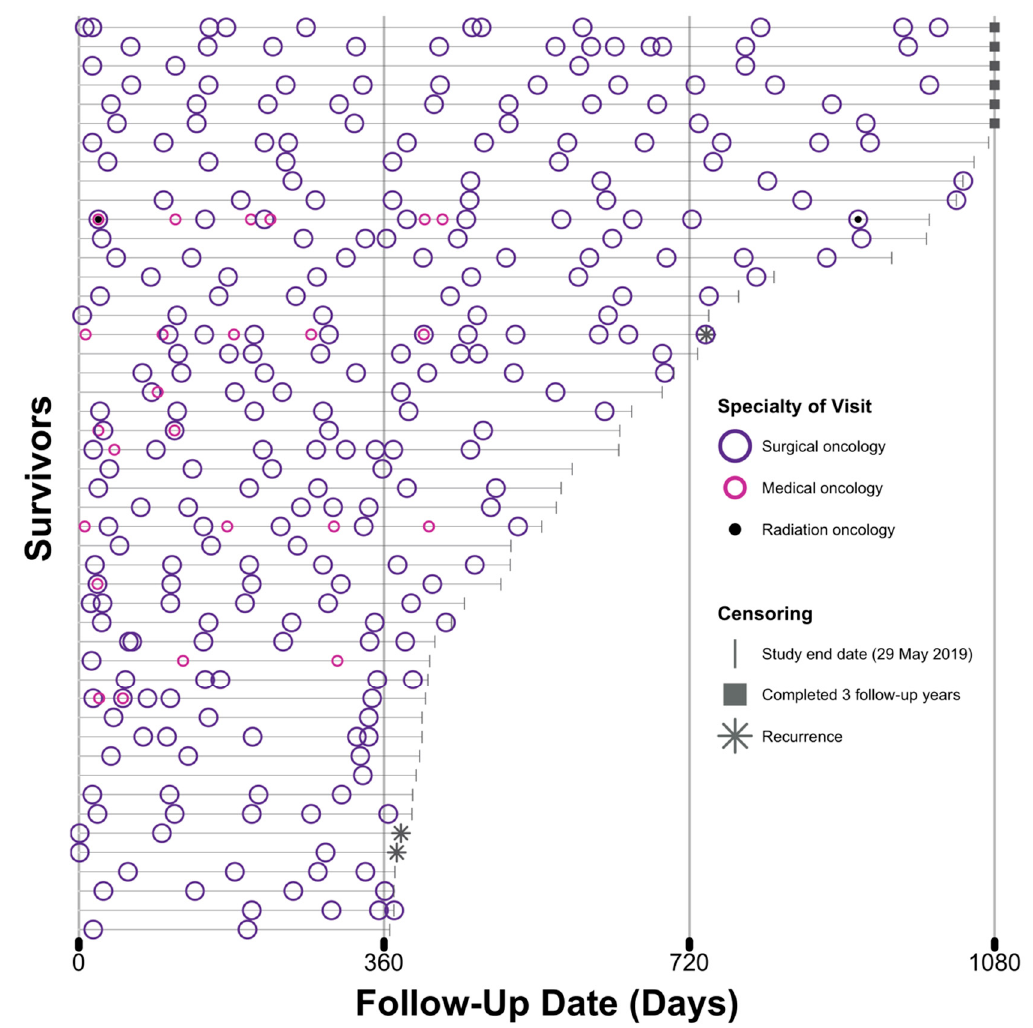
Figure 2. Patterns of follow-up visits in the study population over the observational period ( n = 48). Follow-up visits are represented by circles corresponding to the specialties of surgical oncology (purple), medical oncology (pink) and radiation oncology (black). Each grey horizontal line represents the follow-up period (in days) of an individual colorectal cancer survivor until censoring, as represented by a grey line (study end date), square (completion of three years of follow-up), and star